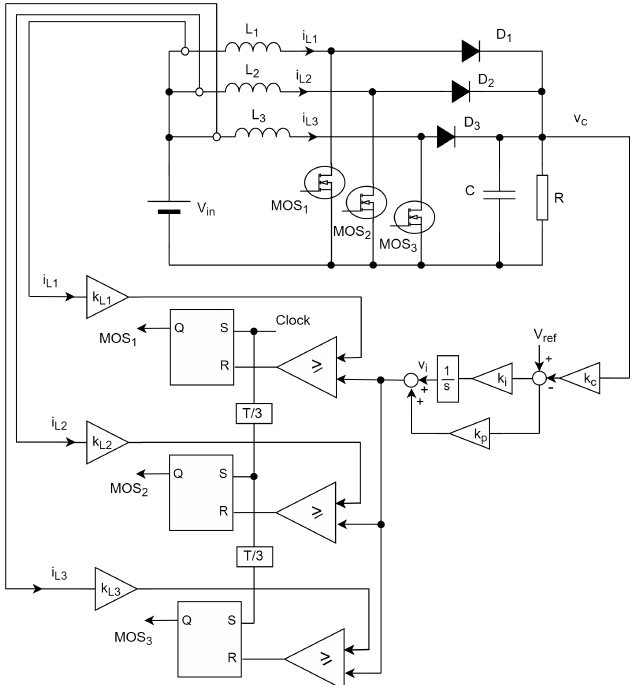
Figure 1. Interleaved boost converter with V in = 14 V, V ref = 2.4 V, L 1 = L 2 = L 3 = L = 560 µ H,